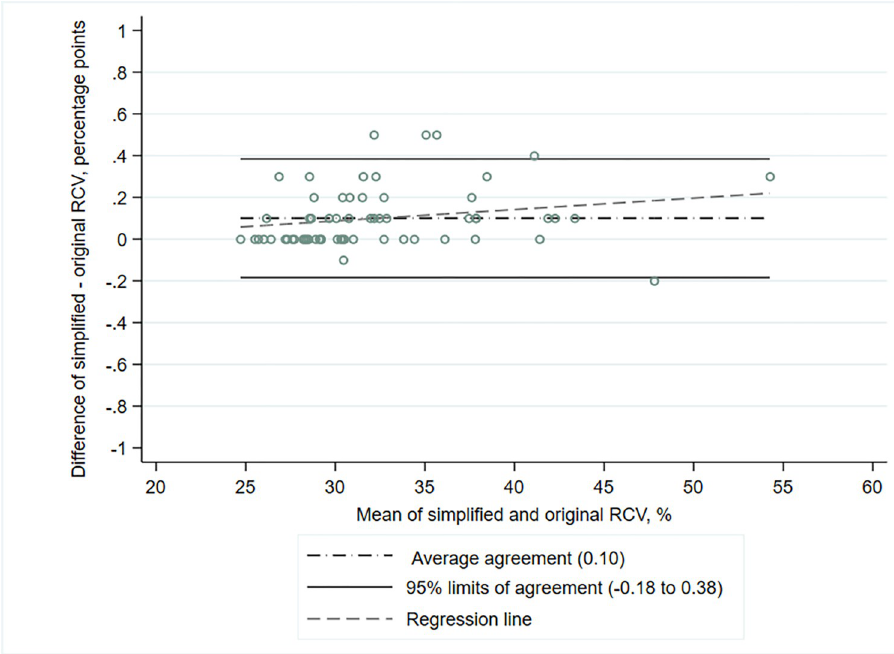
Fig 3. Agreement in continuous intra-individual robust coefficient of variation between simplified and original flow cytometric gating strategies for quantifying peripheral blood neutrophil myeloperoxidase expression (n = 62). Abbreviations: RCV = robust coefficient of variation.